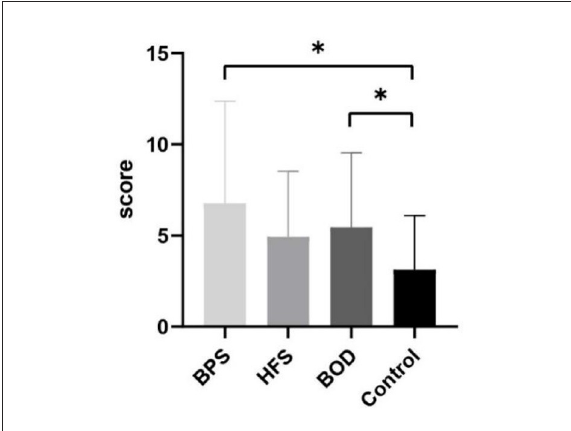
FIGURE2 The comparison of mean HAMA scores between groups. Compare to the control group, BPS ( P = 0.021) and BOD ( P = 0.020) has significantly higher HAMA score. * provides significance P <